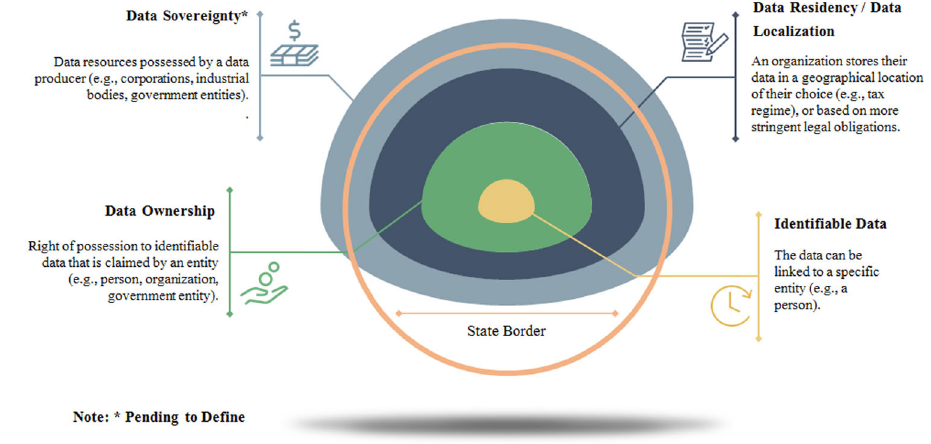
Fig. 1 Lexicon of terms relevant to data